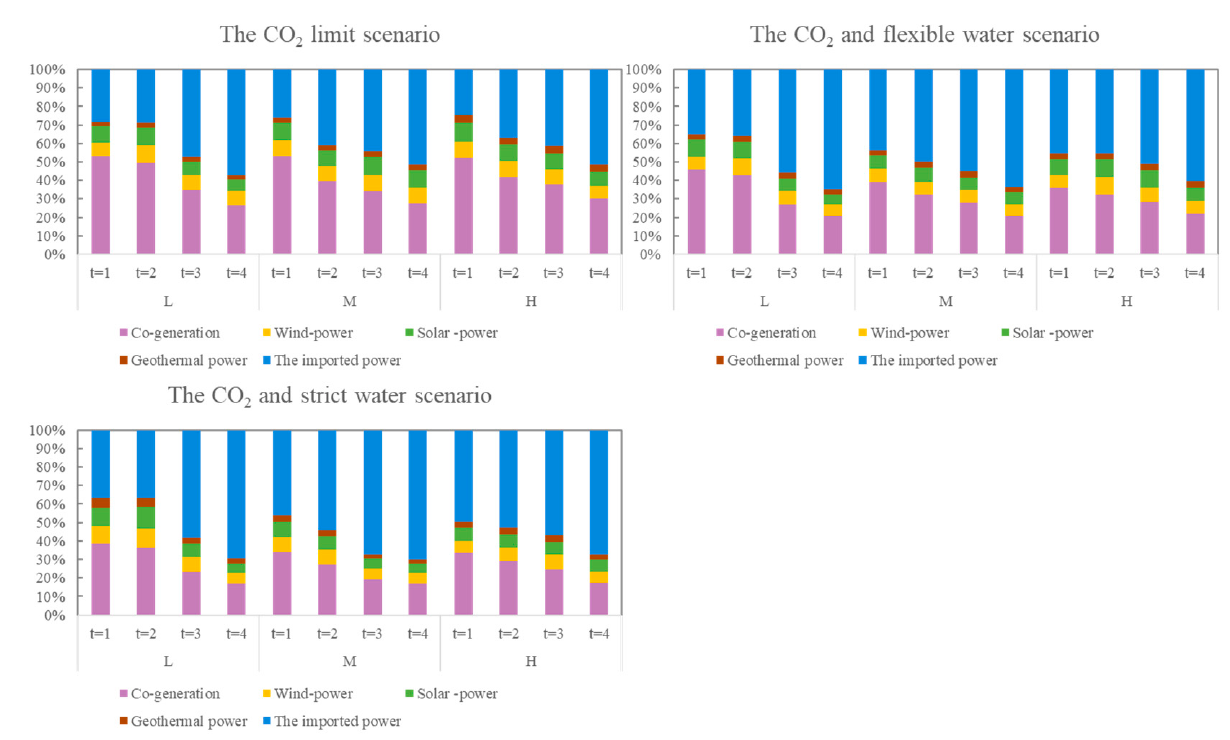
Figure 5. The electric power generation under three DSM scenarios.